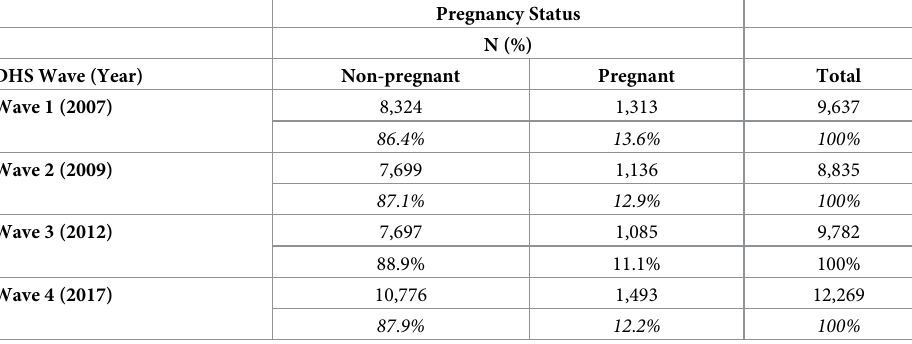
Table 1. Prevalence of pregnant women in Jordan across the four waves of DHS